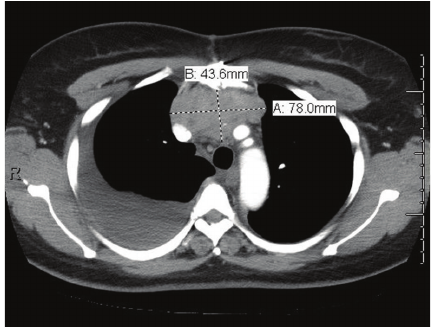
Figure 3: CT scan of the chest after chemotherapy with reduction in size of the